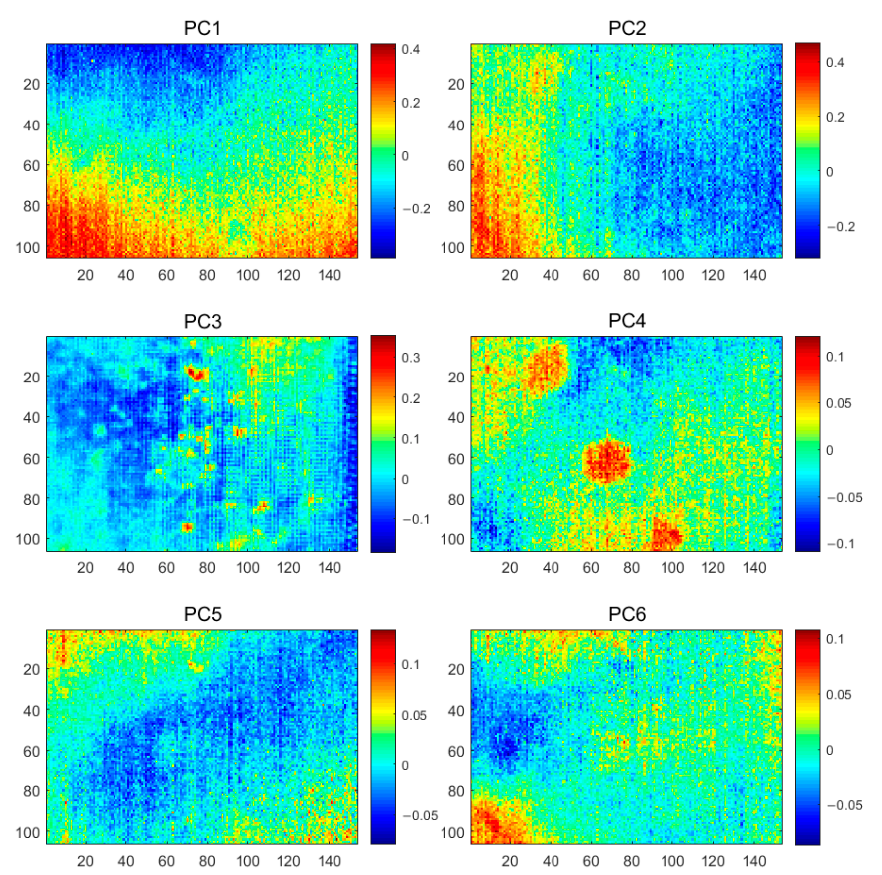
Figure 11. The t-SNE visualization of PT thermograms and SNGAN thermograms.